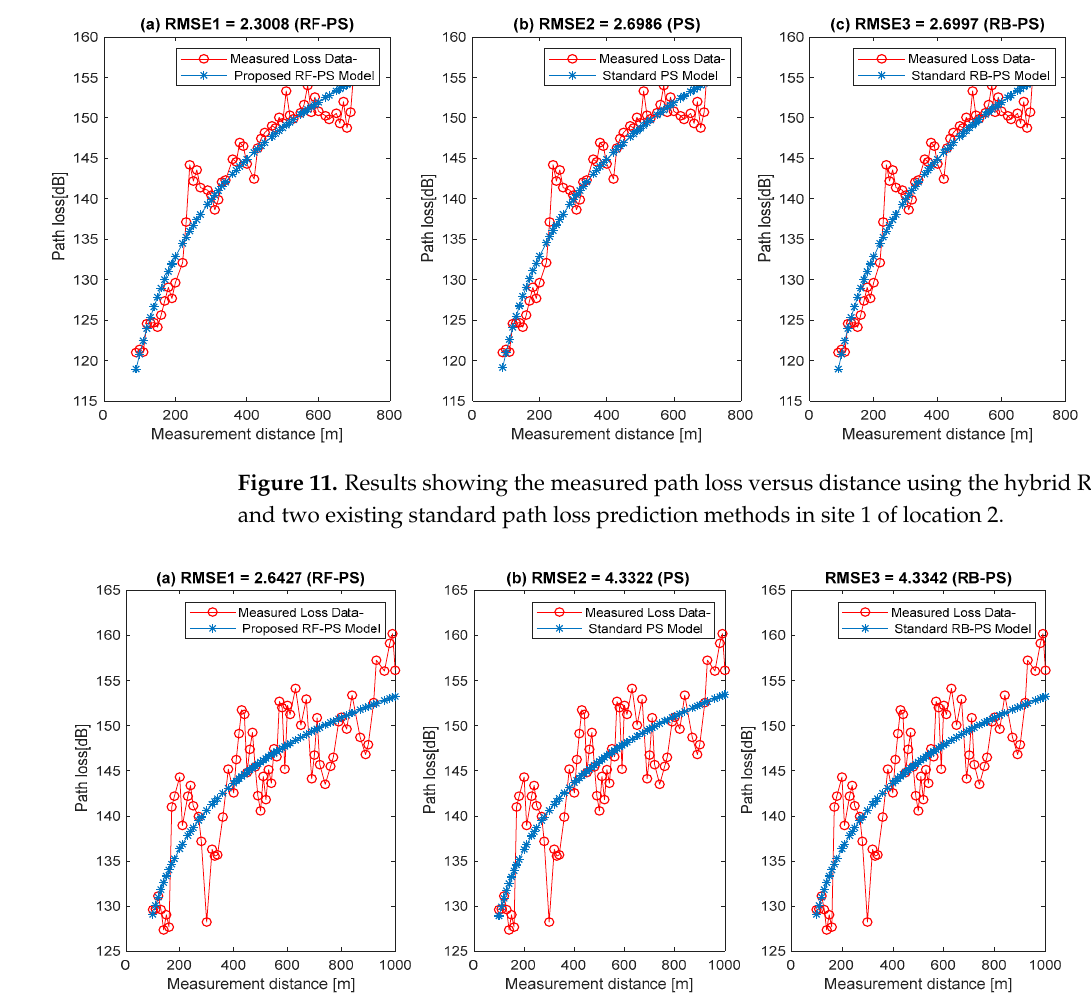
Figure 12. Results showing the measured path loss versus distance using the hybrid RF-PS method and two existing standard path loss prediction methods in site 2 of location 2.